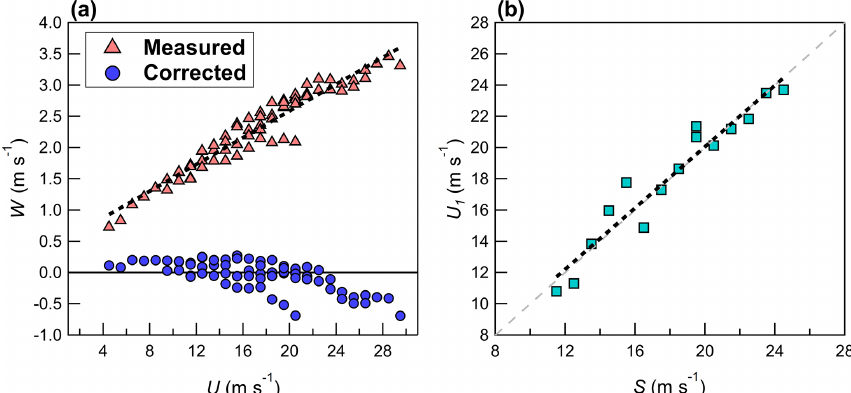
Figure 4. Corrections as shown in Fig. 3, except for 30 August. Black dashed lines give a least-square fit: (a) W = 0 . 45 + 0 . 11 U ( R 2 = 0.96) and (b) U 1 = 0 . 44 + 0 . 98 S ( R 2 =